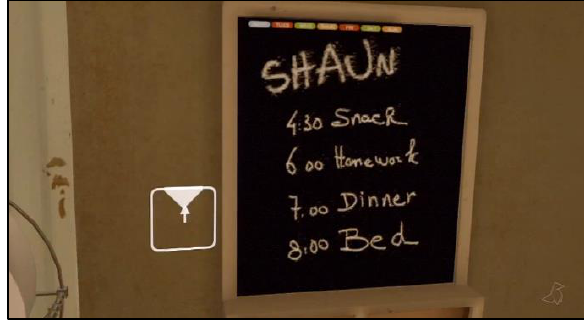
Figure 8 | In the Chapter 3, the rhythm is clocked by the game. Picture from Heavy Rain